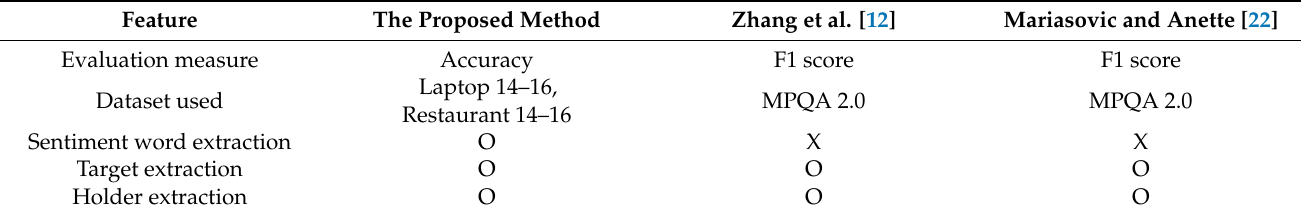
Table 8. Comparison of the proposed method and other